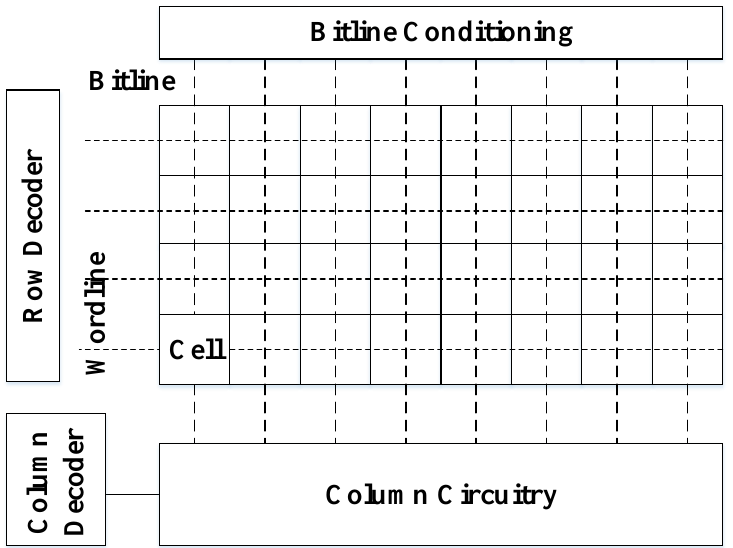
Figure 5. General overview of conventional 2D memory array organization.